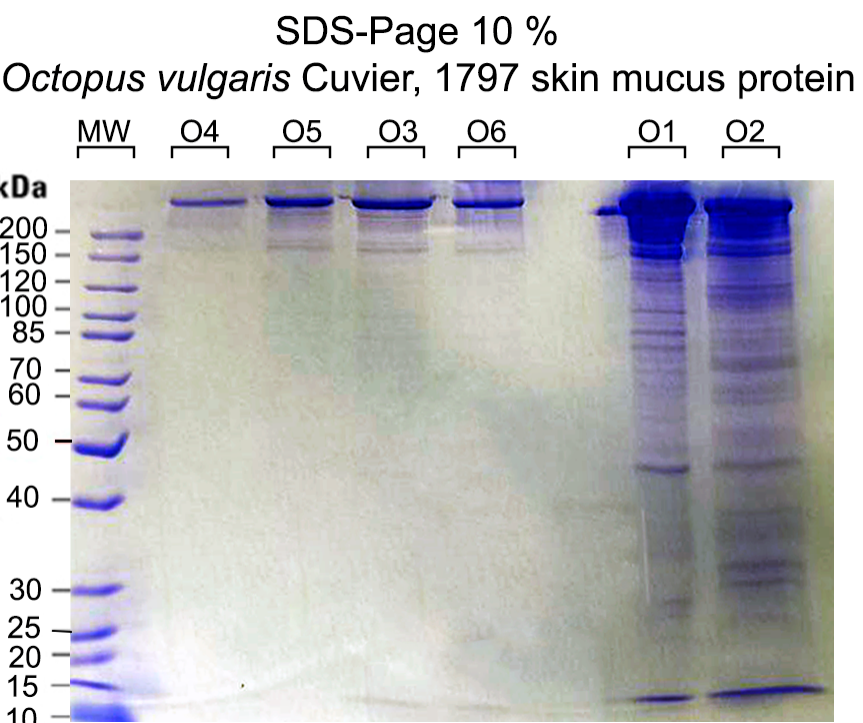
Figure 1. SDS-PAGE 10% profiles of the extracted proteins of O. vulgaris skin mucus samples (O1–O6). MW denotes molecular weight.